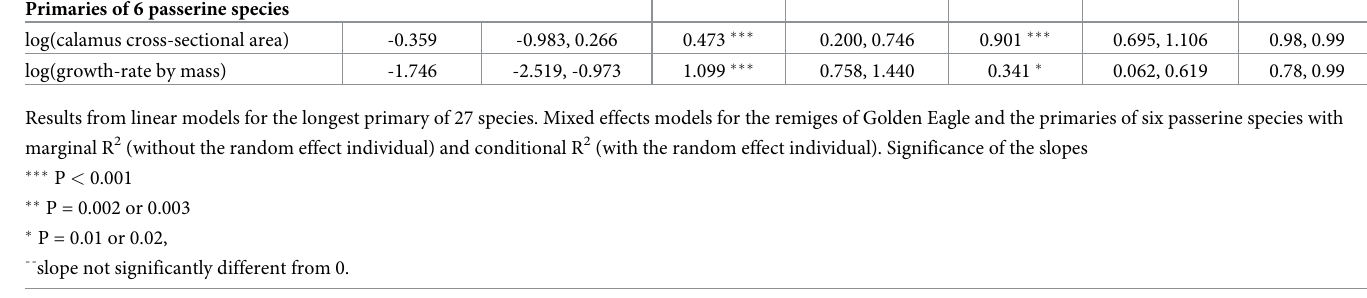
Table). We also tested the combined effects of two feather traits on feather growth-rate by length using GLM and LMM (with individual as a random effect in the latter; S4 Table). For the primaries of six passerine species, we ran both RMA and PhyloRMA analyses for various relationships between the feather traits. PhyloRMA and RMA analyses produced nearly identical results, so that we only present the results of RMA analysis (Tables 1 and 3, S5 Table). We also used LMM to test for an effect of ‘wing-tip primaries’ (binary fixed term) with